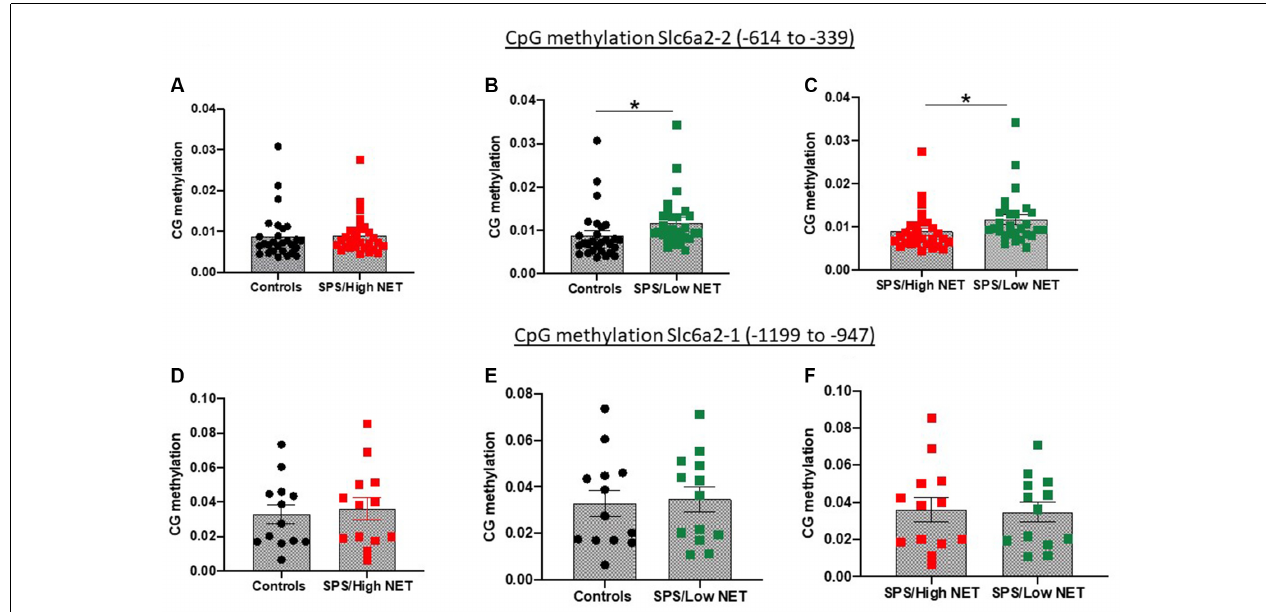
FIGURE 4 | Differences in methylation on two putative CpG islands in the rat promoter of the SLC6A2 gene (coding for NET) in LC of animals with high (A,D) or low NET (B,E) gene expression compared to unstressed controls or to each other (C,F) in the Slc6a2-2 (A–C) or Slc62a2-1 (D–F) regions. Animals ( n = 4 per group) used in the methylation studies were taken from the extremes of animals divided into high and low NET mRNA expression from Experiment 4. Each dot represents a CpG site, * p <